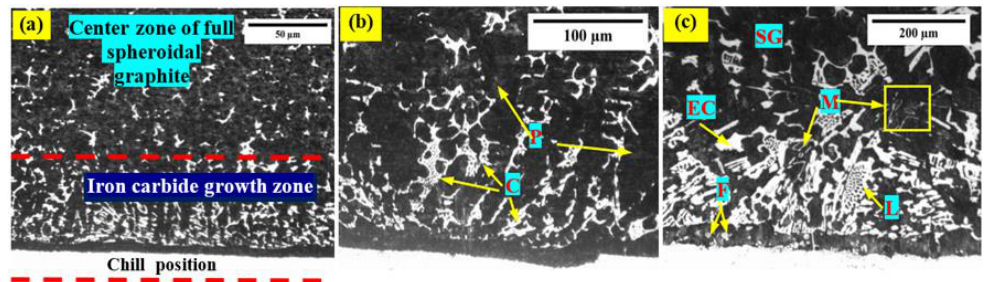
Figure 5: Average microstructure formation on the surface of the samples (S4). (a. microscopic magnification 50x; b. microscopic magnification 100x, c. microscopic magnification 200x). (P=perlite; C=cementite; EC=eutectic carbide; M=martensite; L=ledeburite; F=ferrite; SG=spheroidal graphite).